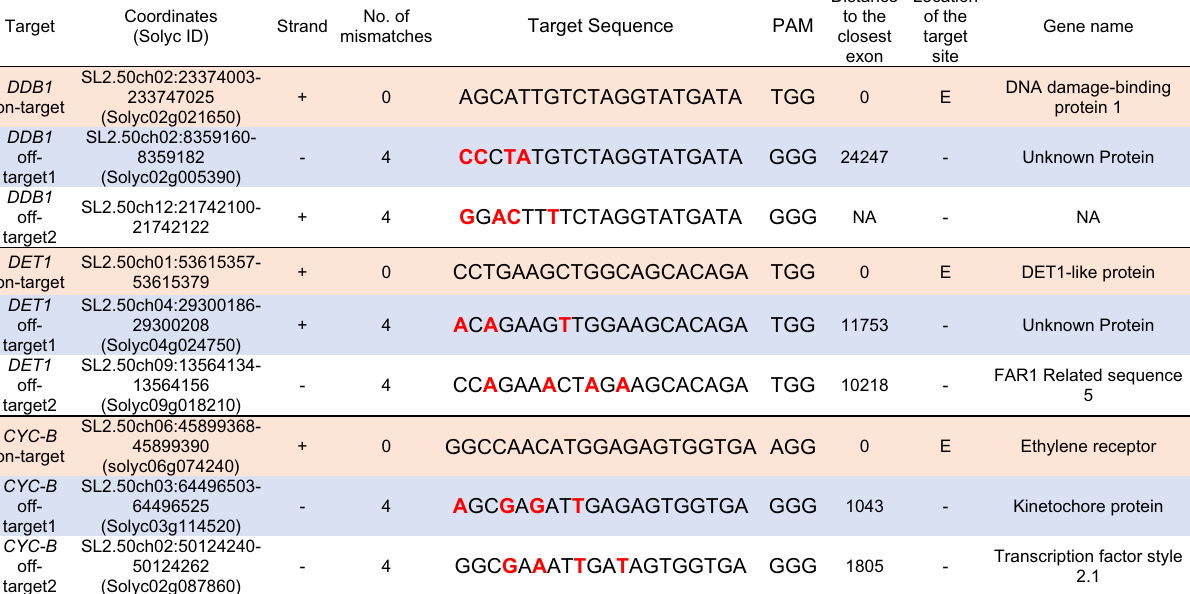
Table 1. Prediction of SlDDB1 , SlDET1 and SlCYC-B off-target sites. Distance to the closest exon: 0 indicates that the target site and exon coordinates overlap; NA indicates that the target sites are farther than 100 kb from the next exon. Location of the target site: E, - indicate exonic, intronic and intergenic,